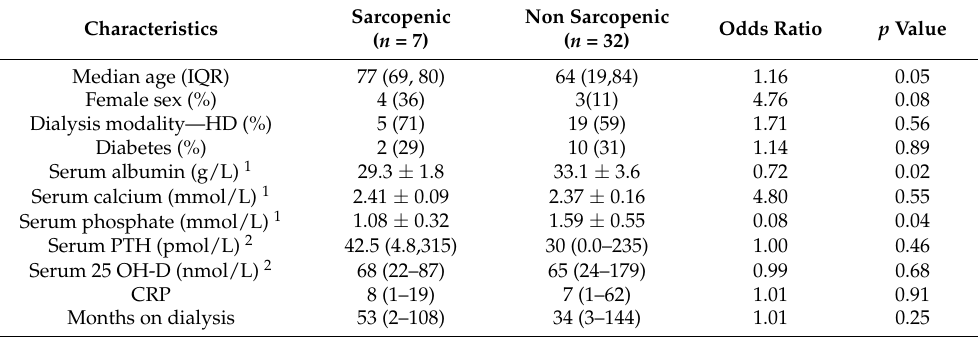
Table 2. Risk factors for sarcopenia in Australian patients on maintenance